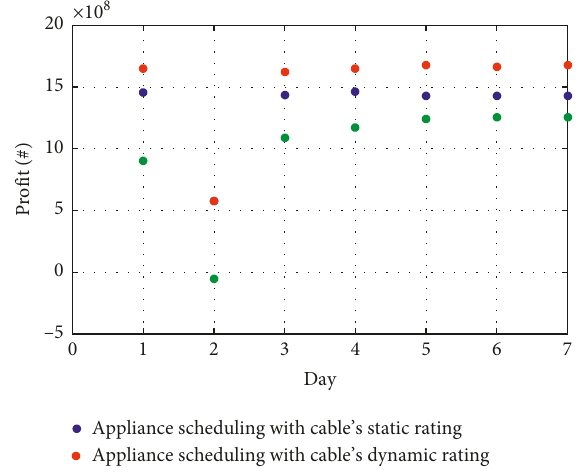
Figure 23: Profit of community for seven days given in Figure 22.